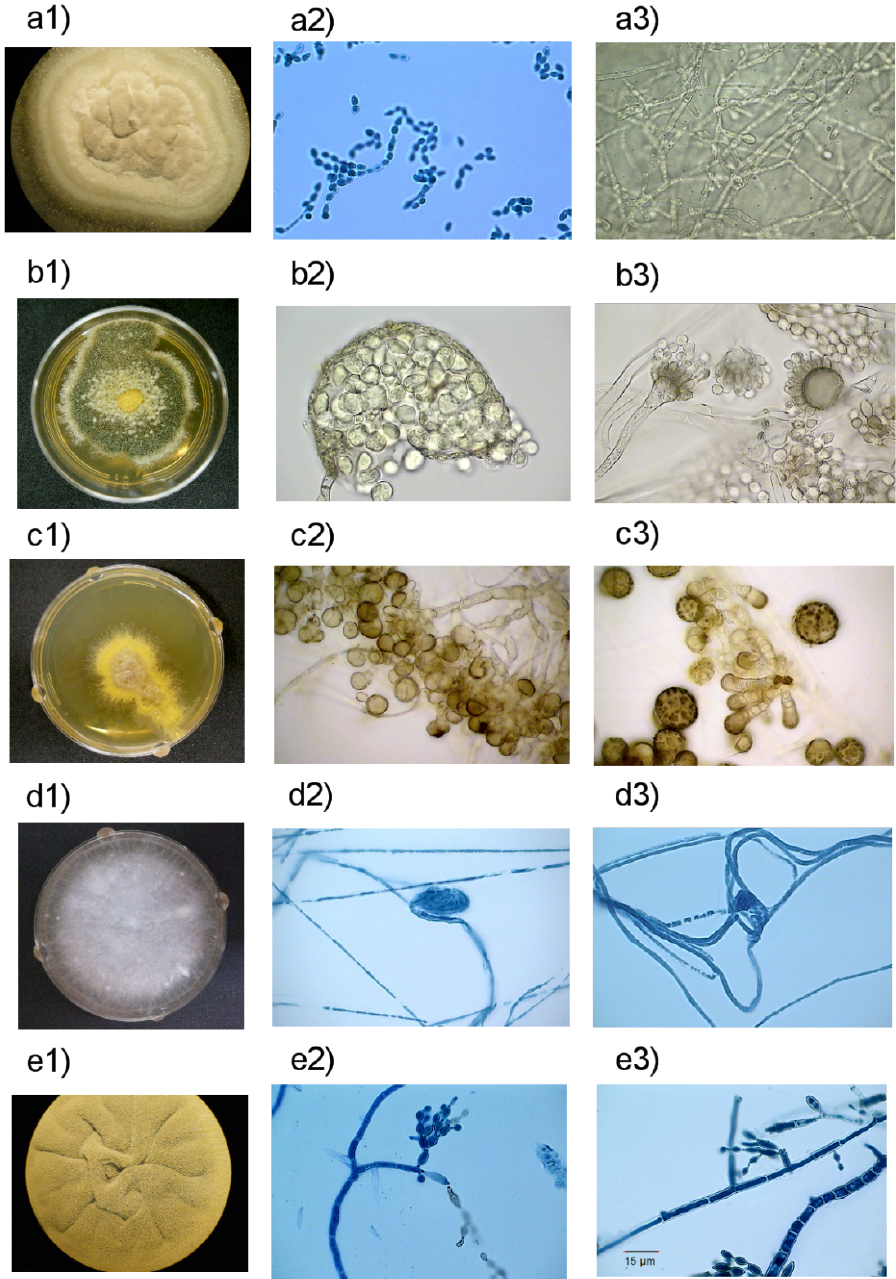
Figure 3: Fungal isolates from marine sediments showing colony morphology, hyphae and reproductive structures stained with and without lactophenol cotton blue using light microscopy, 1000X: a1) - a3) Scopulariopsis sp; b1) - b3) Aspergillus sp; c1) - c3) Phoma sp; d1) - d3) Peniophora sp; e1) - e3) Cladosporium